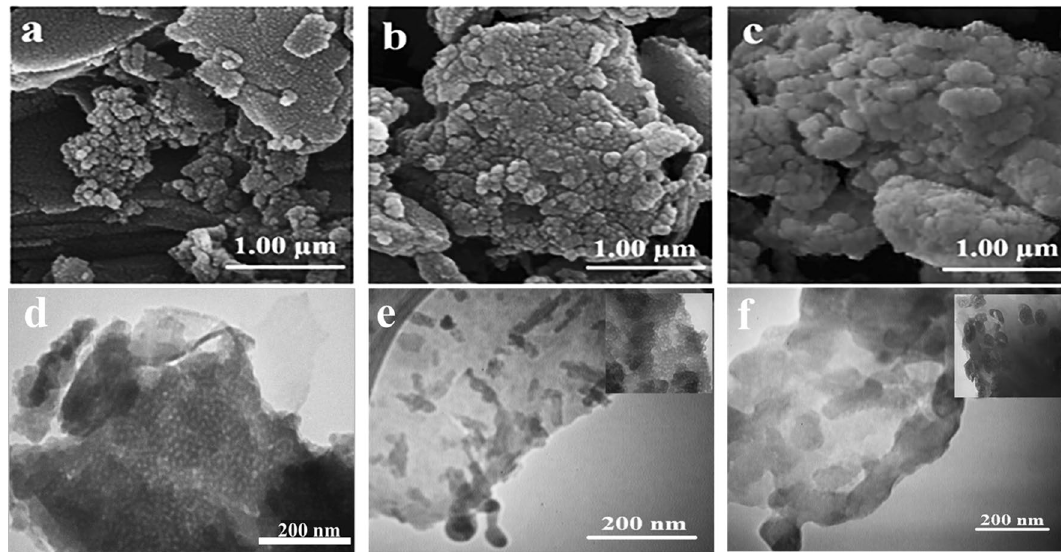
Figure 3. SEM images of zeolite ( a ), xylanase@Lys-zeolite ( b ), and Zeozyme NPs ( c ). TEM images of zeolite ( d ), xylanase@Lys-zeolite ( e ), and Zeozyme NPs ( f ).